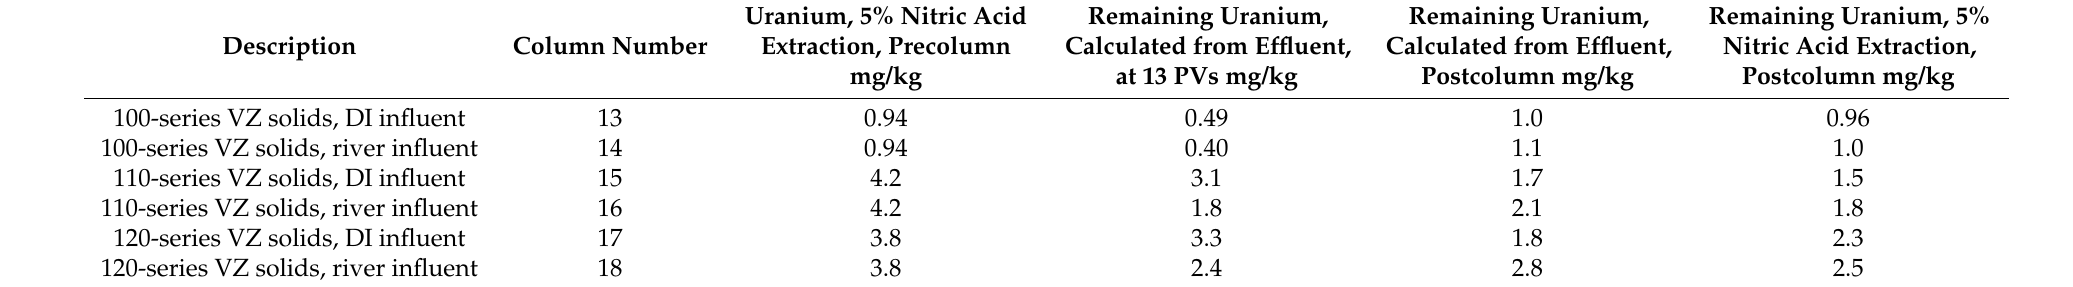
Table 2. Summary of solid-phase uranium concentrations for the VZ